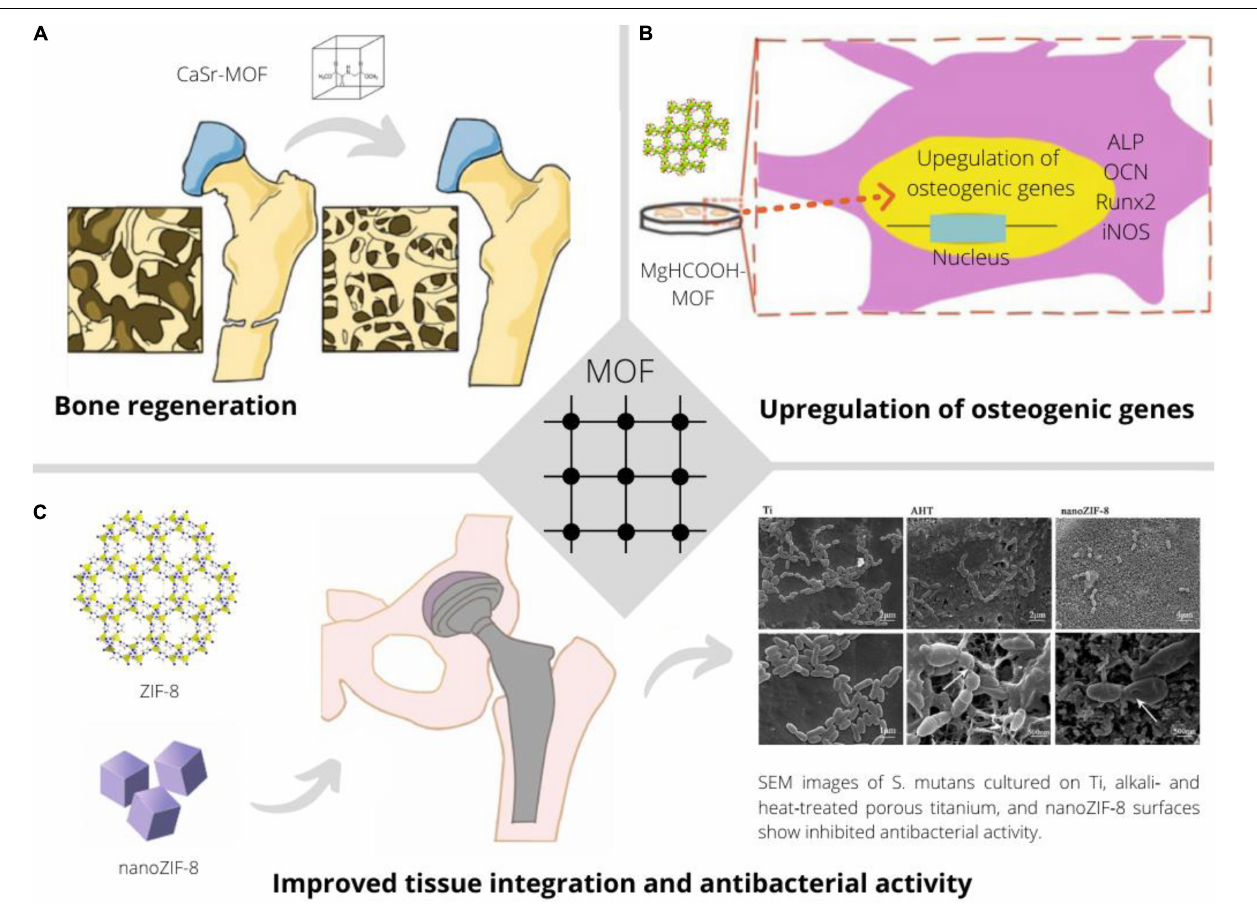
FIGURE 2 | Application of MOFs to improve bone implants through continuous release of earth alkaline ions promoting bone regeneration and biomineralization (Joseph et al., 2019) (A) , facilitating osteo-induction and -integration through favorable upregulation of relevant genes in presence of specific MOFs (Li et al., 2020) (B) and providing improved tissue integration and an anti-bacterial effect (Chen et al., 2017a) (C)